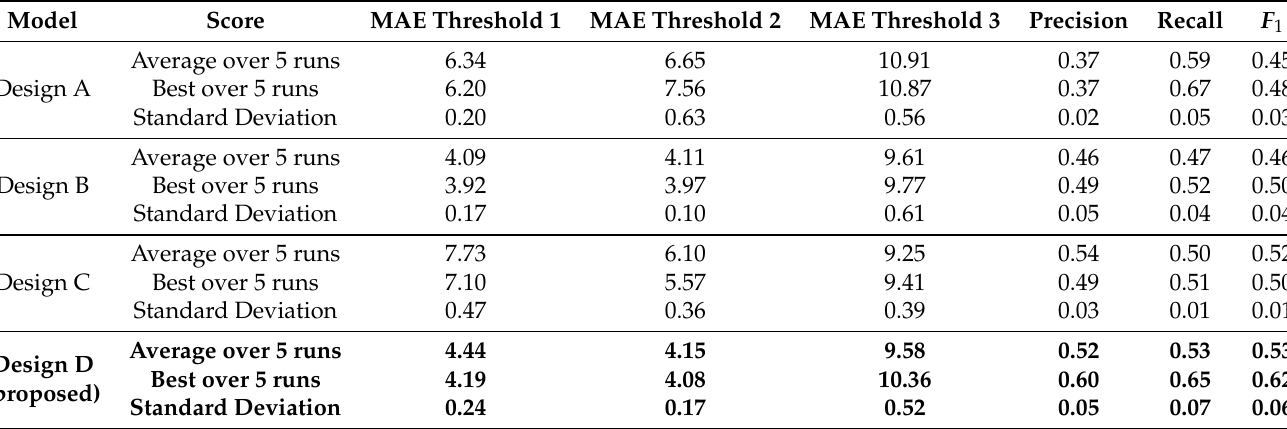
Table 8. Best and average test results out of five runs for anomaly detection using optimised hyperparameters in Table 3 for each NN Design.